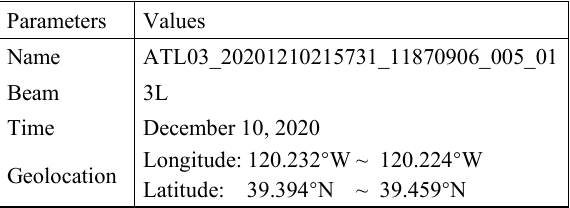
Table 1 . Experimental dataset description.